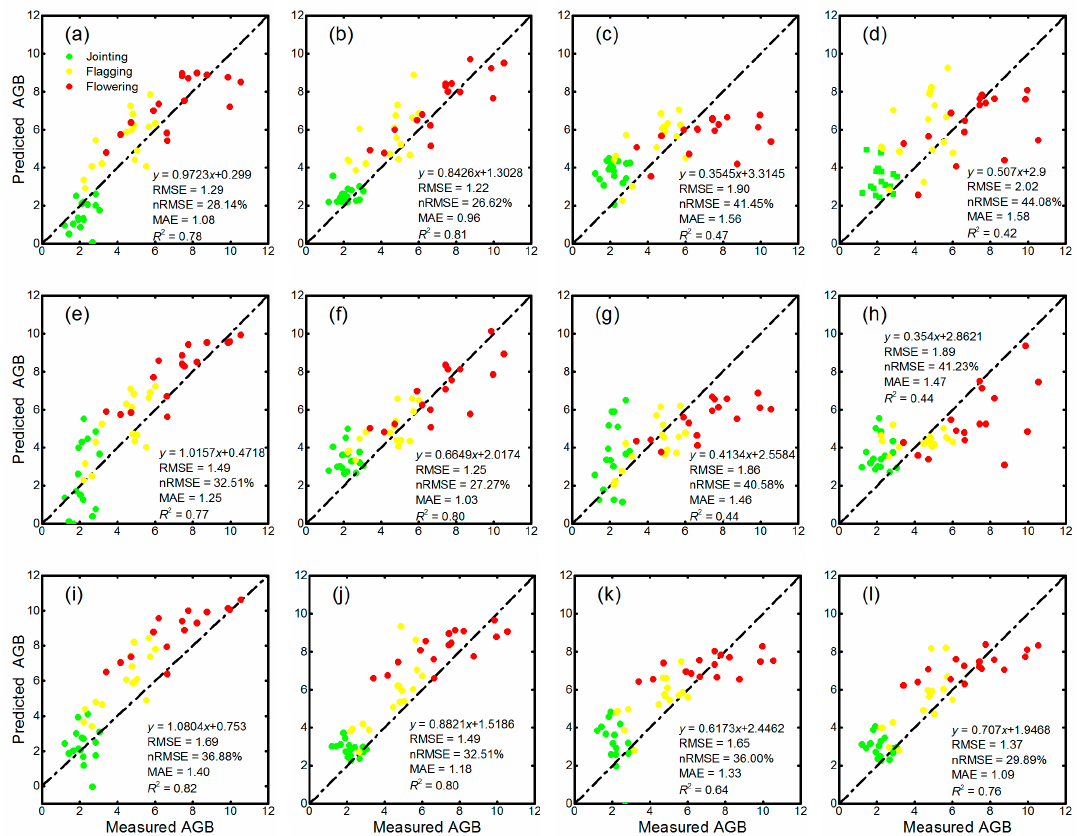
Figure 8. Relationship between the predicted and measured winter wheat AGB (t/ha): ( a ) G-height, VIs, and PLSR; ( b ) G-height, VIs, and RF; ( c ) G-VIs and PLSR; ( d ) G-VIs and RF; ( e ) UHD-height, VIs, and PLSR; ( f ) UHD-height, VIs, and RF; ( g ) UHD-VIs and PLSR; ( h ) UHD-VIs and RF; ( i ) DC-height, VIs, and PLSR; ( j ) DC-height, VIs, and RF; ( k ) DC-VIs and PLSR; ( l ) DC-VIs and RF (validation dataset, mean AGB = 4.58 t/ha).